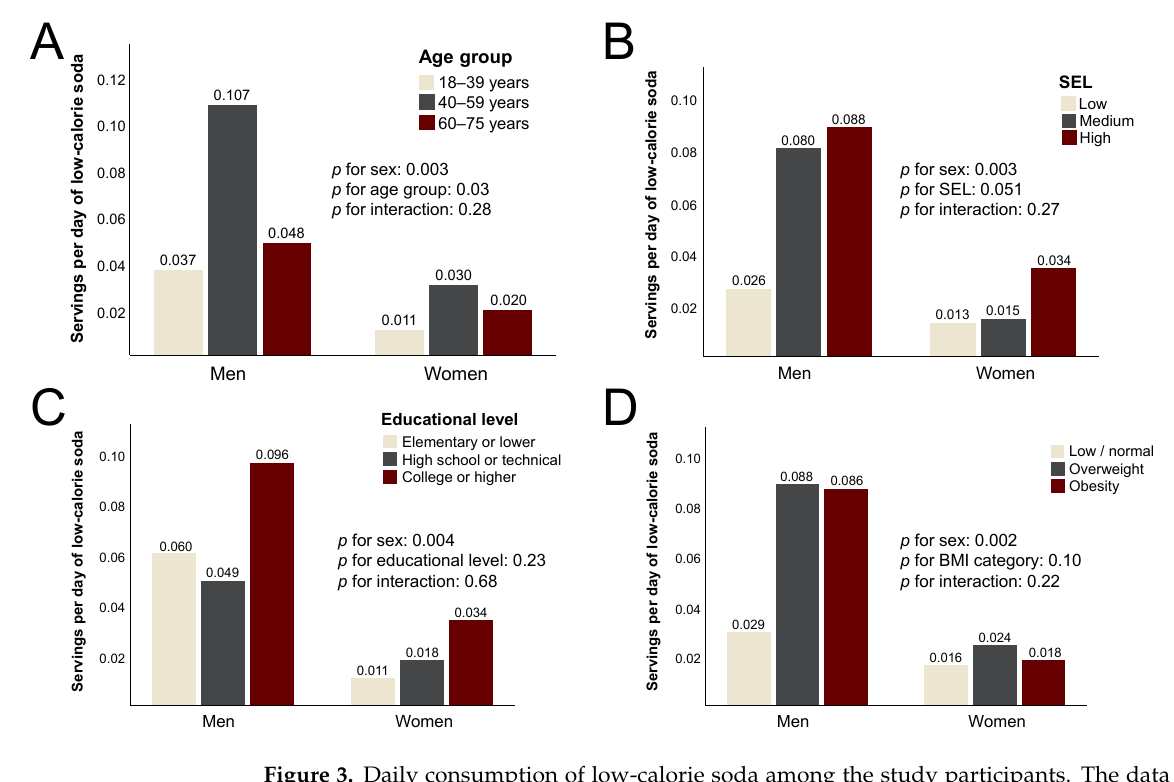
Figure 3. Daily consumption of low ‐ calorie soda among the study participants. The data are the mean servings per day according to ( A ) age group; ( B ) socioeconomic level (SEL); ( C ) educational level; ( D ) body mass index (BMI) category. The consumption of homemade fruit juice was similarly high across age, SEL, edu ‐ cation and BMI ‐ defined categories in both sexes (Figure 4), with no statistically significant differences.